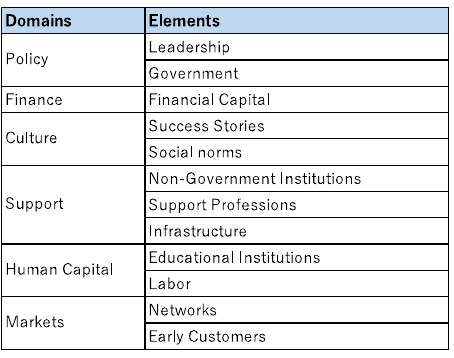
Table 2. Domains and elements of